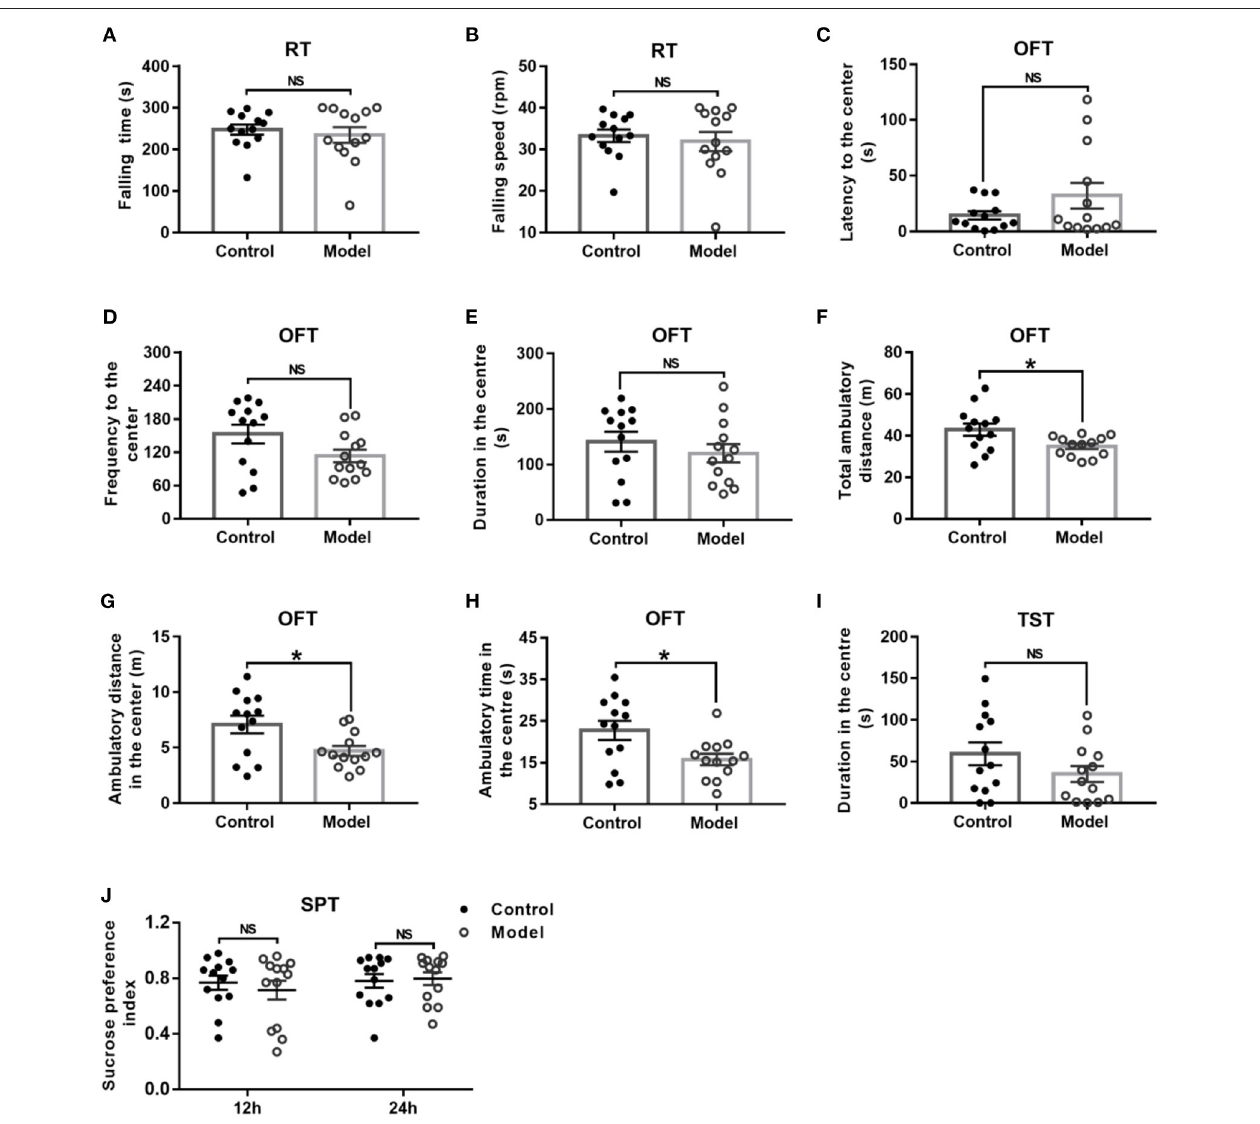
FIGURE 3 | Effect of bilaterally hippocampal injection of STZ on the behavior performance of mice in the RT, OFT, TST, and SPT. The data are presented as the mean ± SEM, with 13 mice in each group. There was no significant difference between the two groups as regard to the falling time (A) and falling speed (B) in the RT. In the OFT, although there was no significant difference in the latency (C) and frequency (D) to the center, duration (E) in the center between the two groups, bilaterally hippocampal STZ-injected mice showed significant decreased total ambulatory distance traveled (F) in the area, as well as the ambulatory distance (G) and time (H) in the center zone than control mice. The immobility time (I) in the TST and the SPI (J) in the SPT are not remarkably different between groups. * P < 0.05; compared with the control group, NS is no significance.